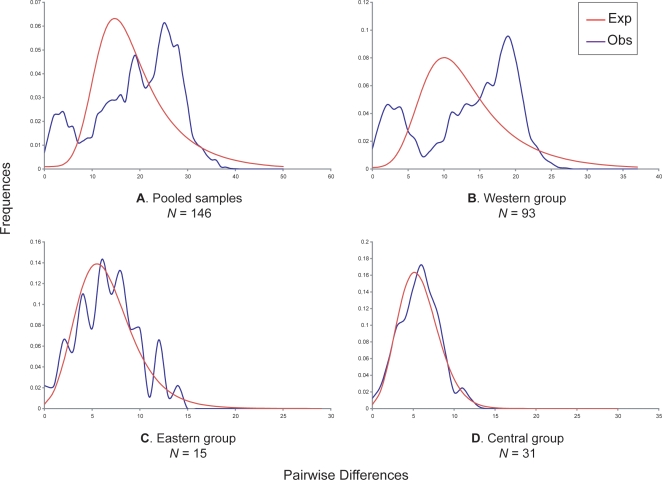
Demographic history of Microtus arvalis inferred from cytochrome b gene dataset.Observed mismatch distributions (blue line) for the whole dataset (A) as well as the Western (B), Eastern (C) and Central (D) lineages are compared to expected distributions under a population growth-decline model (red line). Numbers of pairwise differences are on the X-axis, while relative frequencies are on the Y-axis.